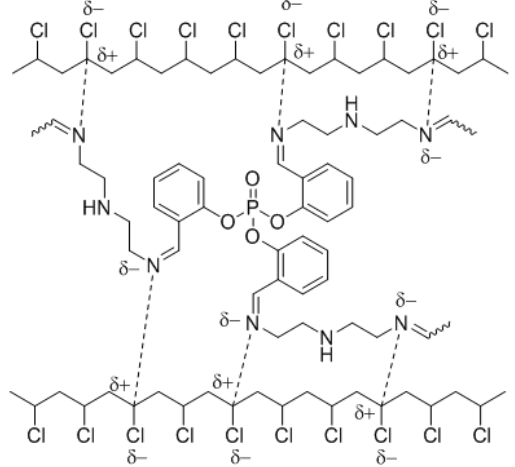
Figure 18. Interaction between polyphosphate 1 and PVC chains.